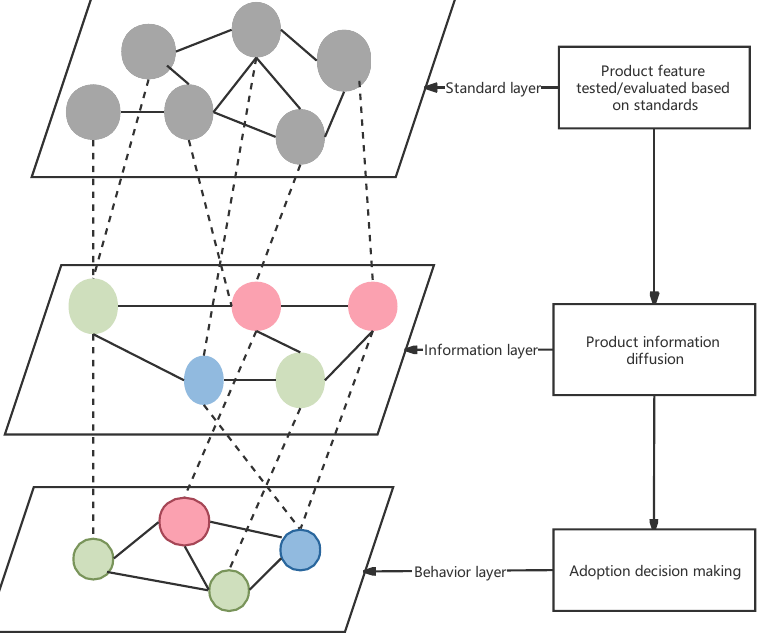
Figure 3. Illustration of standard-information-behavior framework.